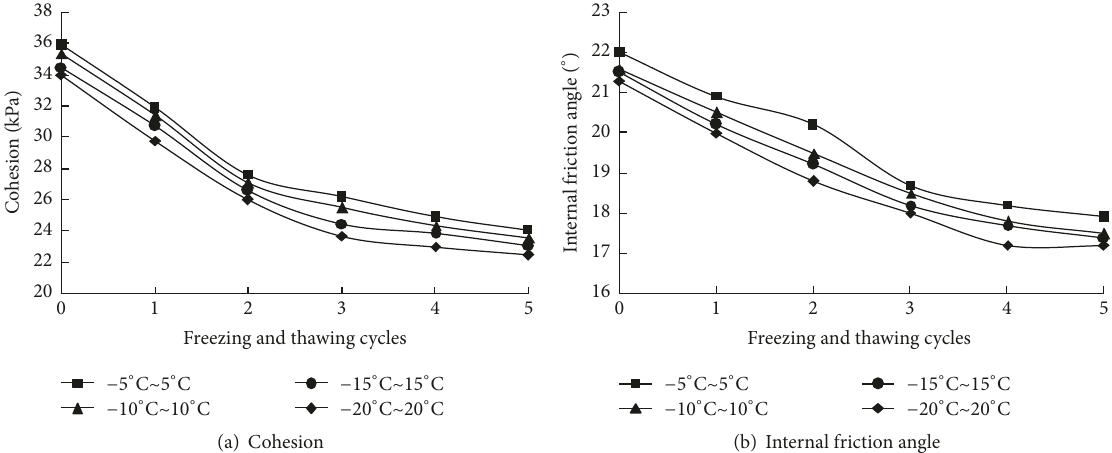
Figure 7: The change of cohesion and internal friction angle with the freezing and thawing